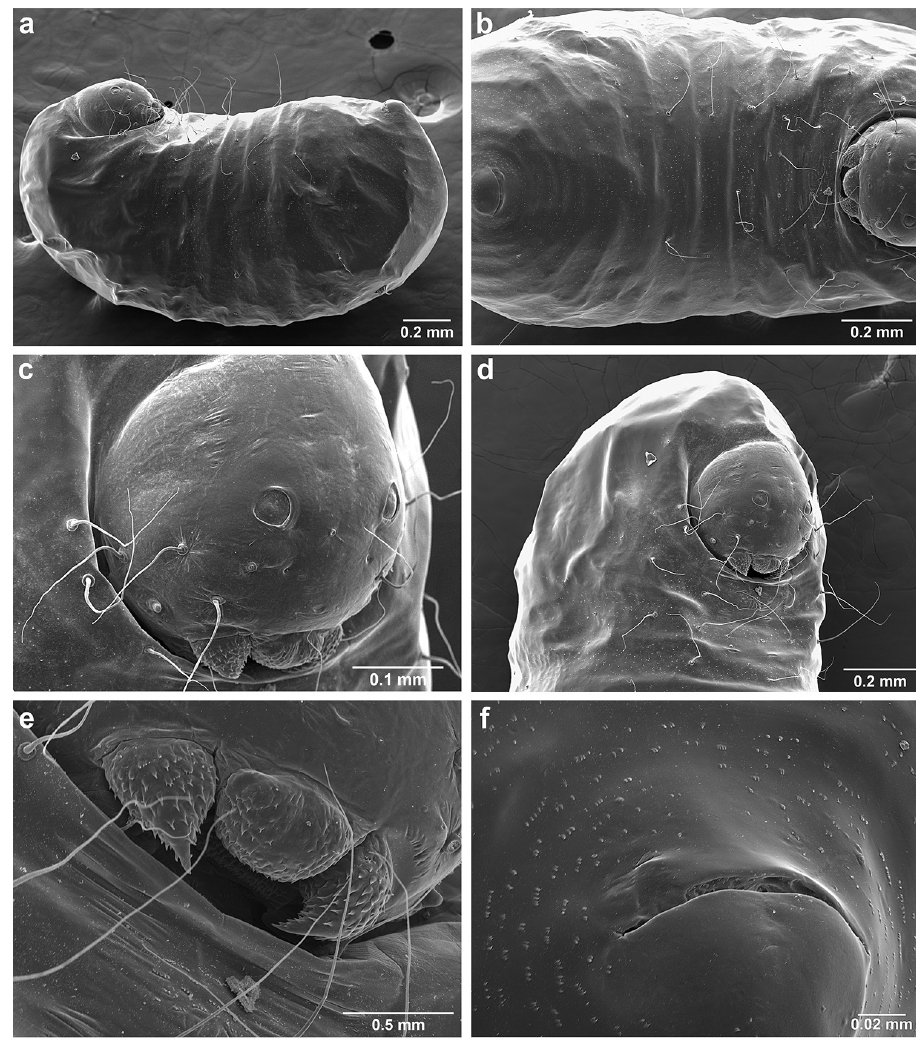
Figure 46. S. opacus larva (USNMENT01125317), SEM images. a Lateral view b ventral view c head, frontolateral view d head and thorax, frontolateral view e mouthparts f anal setae. verse rows. Numbers of ventral hairs: six on each thoracic segment, eight on the abdo- men (not including anal setae). Single pair of sensilliform setae anterior to anal opening. S. opacus geographic range. Brazil, Central America, Colombia, Mexico. Map: Figure